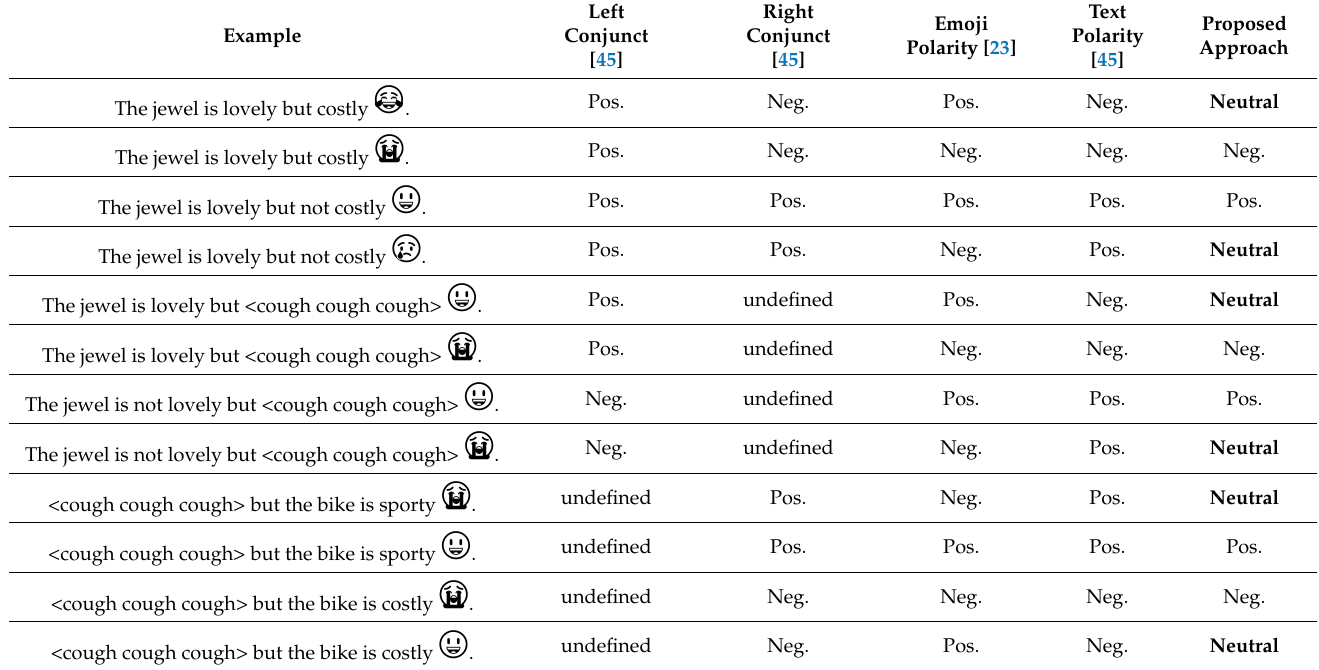
Table 4. The polarity of sentences based on the commonsense concept and context generated from patterns of text and multiple emojis used in a sentence.